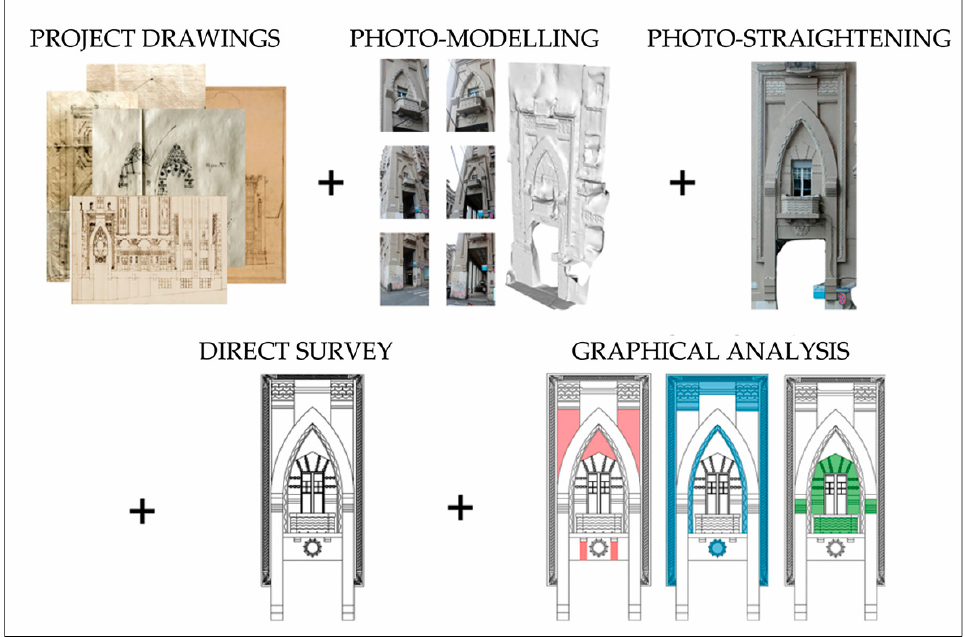
Figure 2. Integration and comparison of data from different analyzed for the knowledge of the